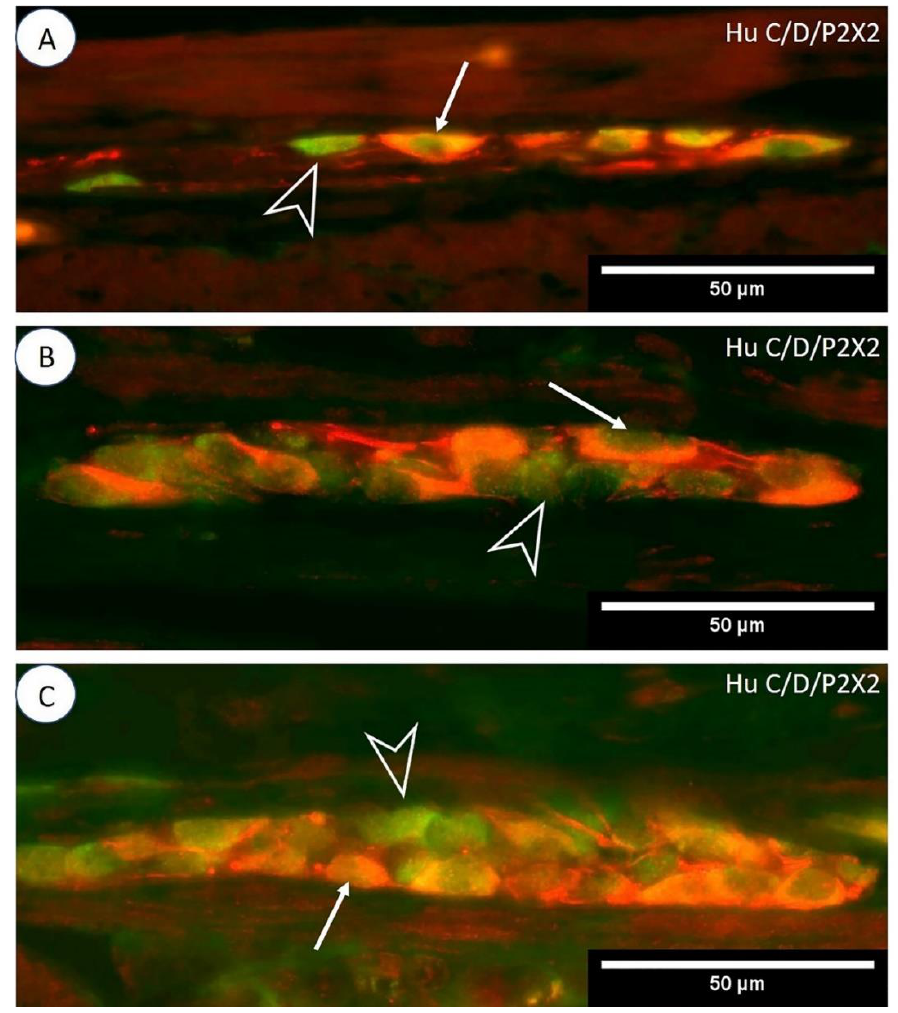
Figure 2. Immunoexpression of P2X2 receptors in porcine jejunum. Photos ( A – C ) show P2X2 double immunofluorescence staining with a Hu C/D neuronal marker in MP, OSP, and ISP ganglia (respectively). The arrow indicates Hu C/D-IR/P2X2-IR neurons, and the empty arrowhead indicates Hu C/D-positive/P2X2-negative neurons.